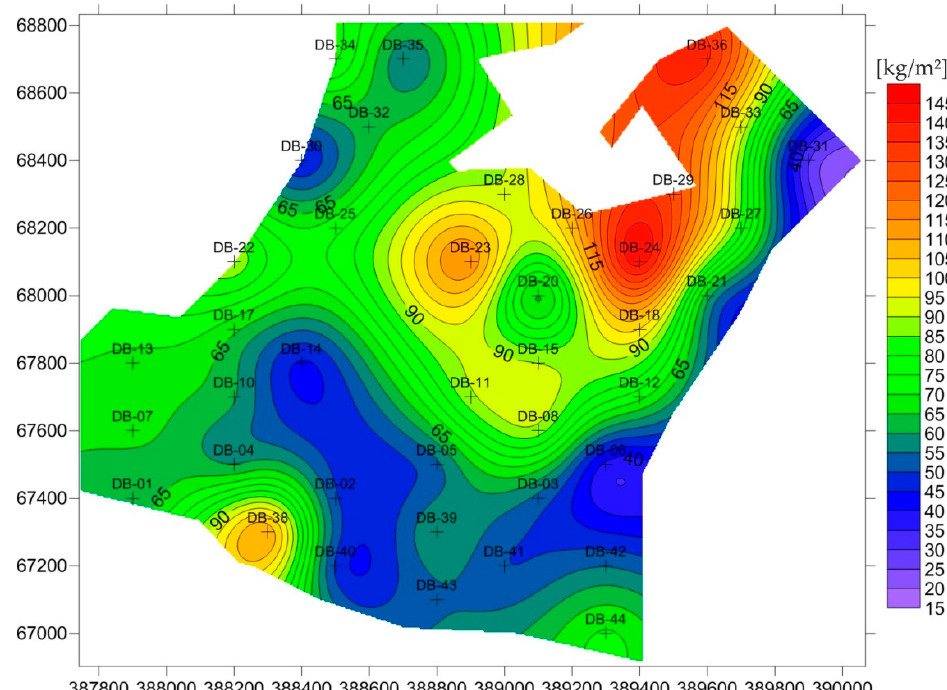
Figure 12. Nickel resources (kg/m 2 ) throughout the deposit profile in the area of block B. Inter- and extrapolation of data between exploration points performed for illustration purposes using the Radial Basis Function (RBF) method. WGS 84 UTM 52N coordinate system. Made in Surfer 9 software (Golden, CO, USA).